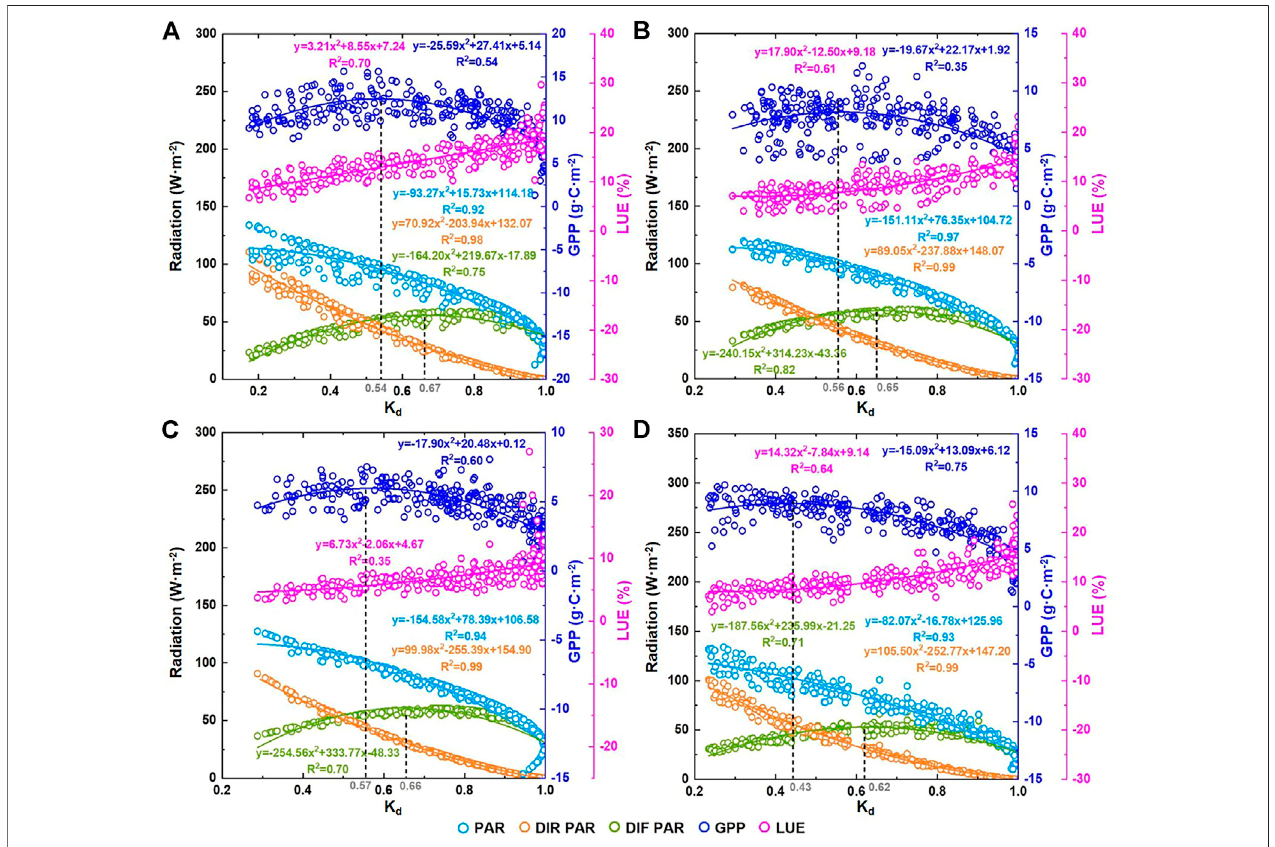
FIGURE 7 | The relationship among K d , PAR and GPP. (A – D) are Cha, Qia, Din and MPM sites, respectively.